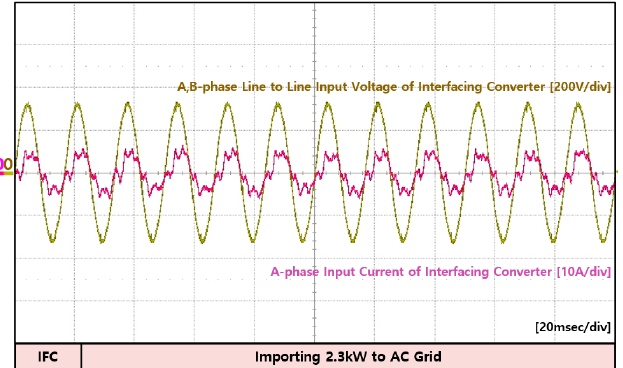
Figure 26. Experiment waveforms of interfacing converter and WT converter in mode 5.